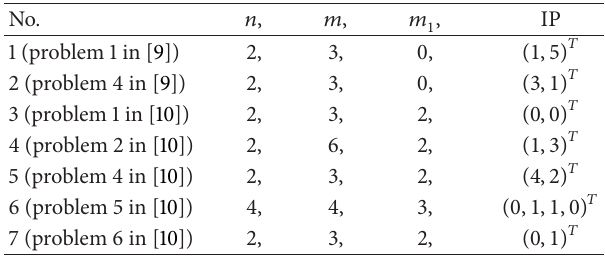
Table 1: The information of numerical experiments.